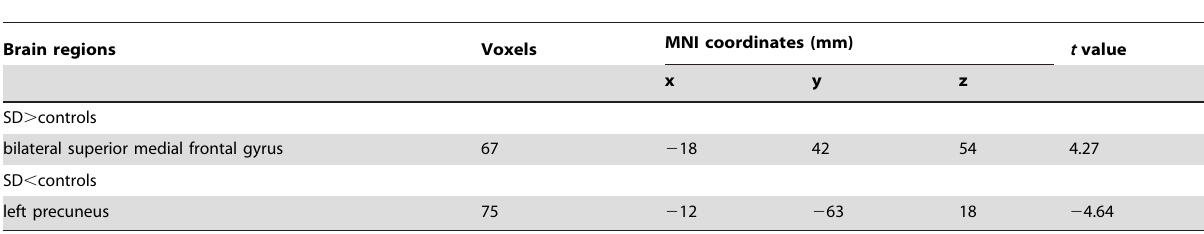
Table 2. Regions showing fALFF differences between groups.